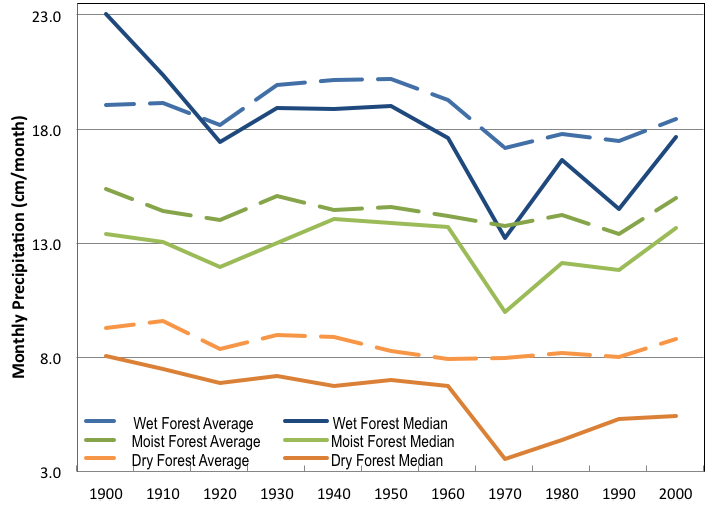
Figure 3. Decadal trends in Average and Median Monthly Precipitation for Puerto Rico’s